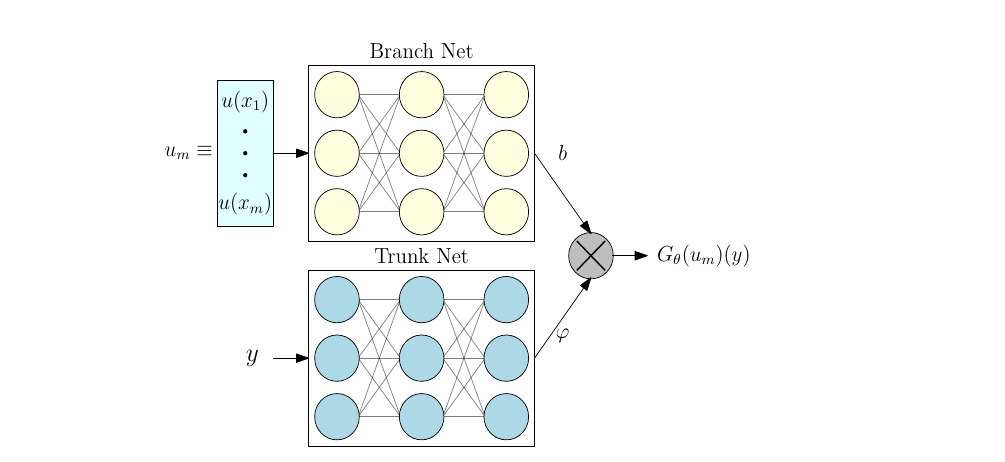
Figure 1. The DeepONet’s architecture. The Branch (resp. Trunk) network processes the input function u m (resp. query location within the output function domain y ∈ Y ). The DeepONet’s output uses a dot product (represented via a crossed node) to fuse the trainable coefficients of the Branch’s output ( b ∈ R q ) with the trainable basis functions of the Trunk’s output ( ϕ ∈ R q